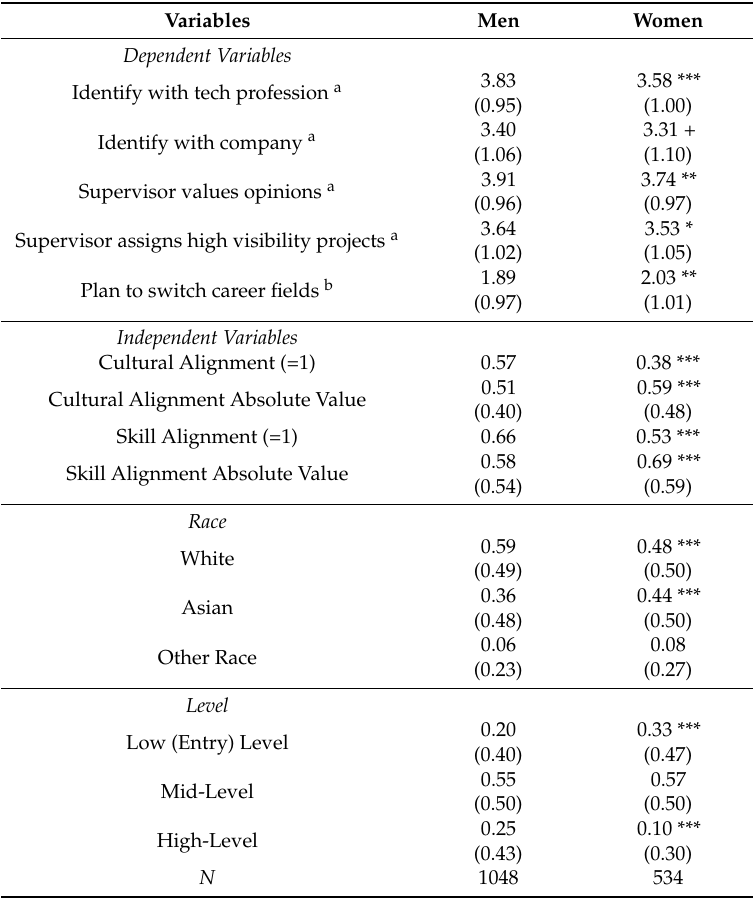
Table 1. Means and Standard Deviations of Variables used in the Analyses of the Relationship between Alignment and Workplace